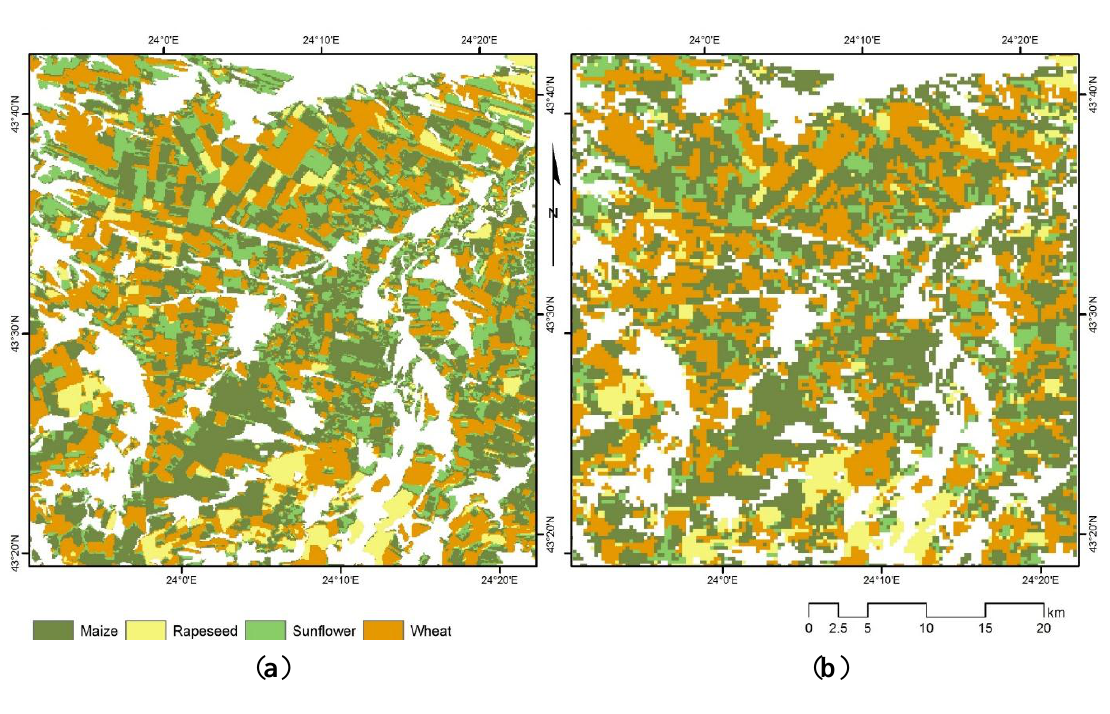
Figure 4. Classification results using multi-date PROBA-V multi-spectral images at ( a ) 100 m and ( b ) 300 m resolution (experiment MULT1: 21 March, 4 April, 7 June, and 8 July 2014)